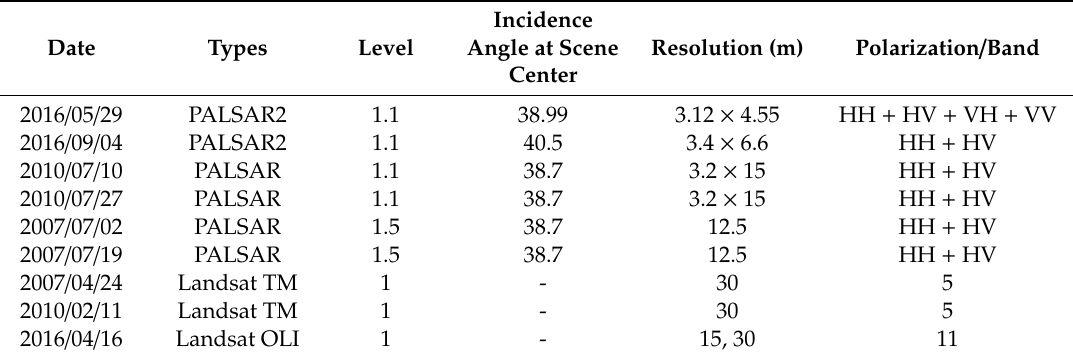
Table 1. Characteristics of satellite image data used in this